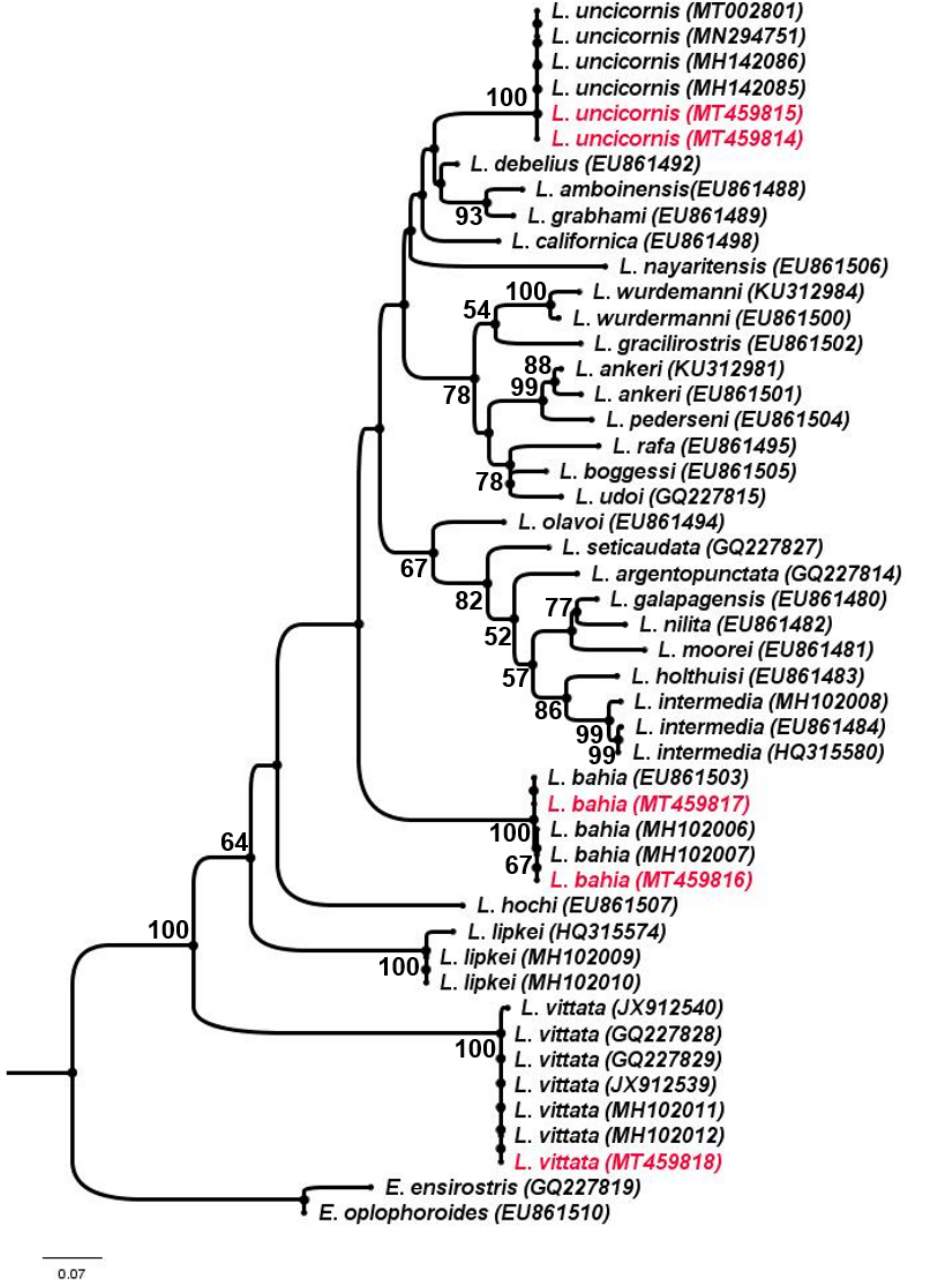
Figure 3. Phylogenetic tree of genus Lysmata (Risso, 1816), including Lysmata bahia Rhyne and Lin, 2006, Lysmata uncicornis Holthuis and Maurin, 1952, and Lysmata vittata (Stimpson, 1860) from Queimada Grande Island, Brazil (indicated in red), constructed via Maximum Likelihood analysis of the 16S DNA gene. Numbers are support values for 1000 bootstraps; values < 50 % were not